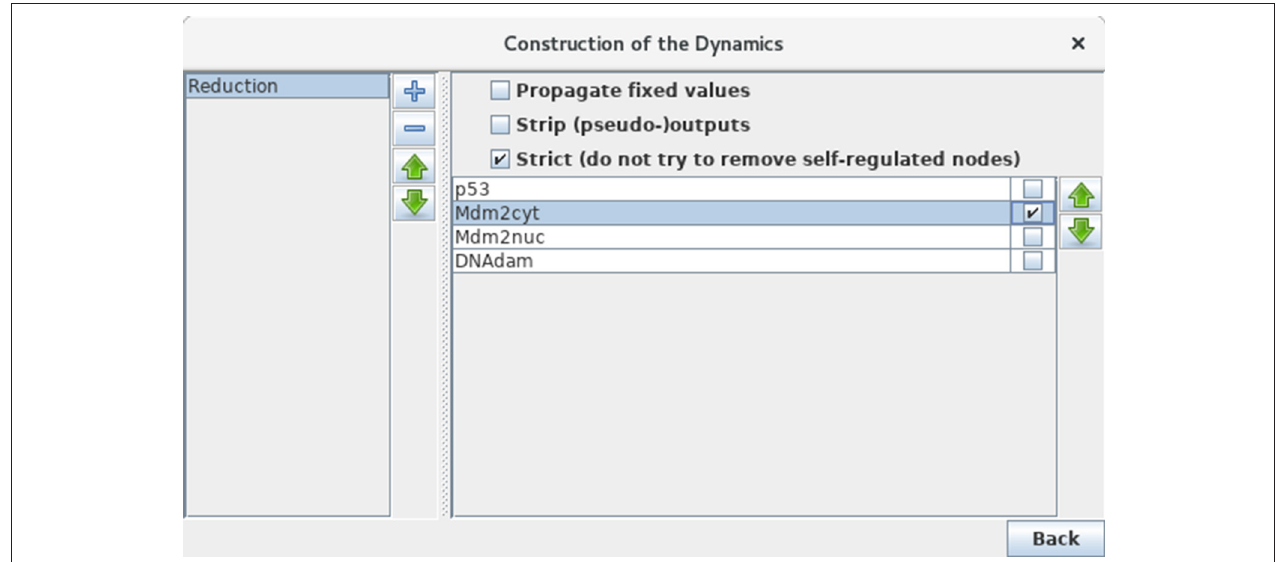
FIGURE 12 | Model reduction. This window appears following the selection of Reduce model from the Tools scrolling menu in the main GINsim window. Here, only Mdm2cyt has been selected for reduction. By hitting the Run Button, a reduced model is generated, provided that no self-regulated node is affected. Alternatively, one can close the window after the definition of one or several reduction(s) (the + button on the left enable to create new reductions) and then select a predefined reduction directly when performing simulations or other kinds of analyses.